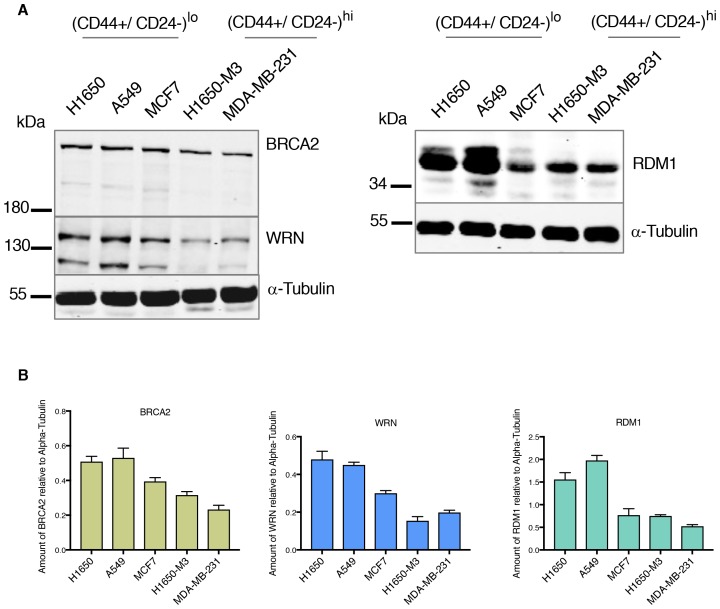
Differential expression of HDR genes in multiple tumor-derived cell lines at protein level.(A) Expression of BRCA2, WRN and RDM1 in multiple cancer-derived cell lines characterized by different CD44 CD24 immune types. α-Tubulin is used as a loading control. (B) The charts depict the quantification of relative amounts of BRCA2, WRN and RDM1. Levels of intensity of each band were quantified using imajeJ32 software and are represented as a ratio to α-tubulin. Each bar represents the mean ± SD from two independent experiments.